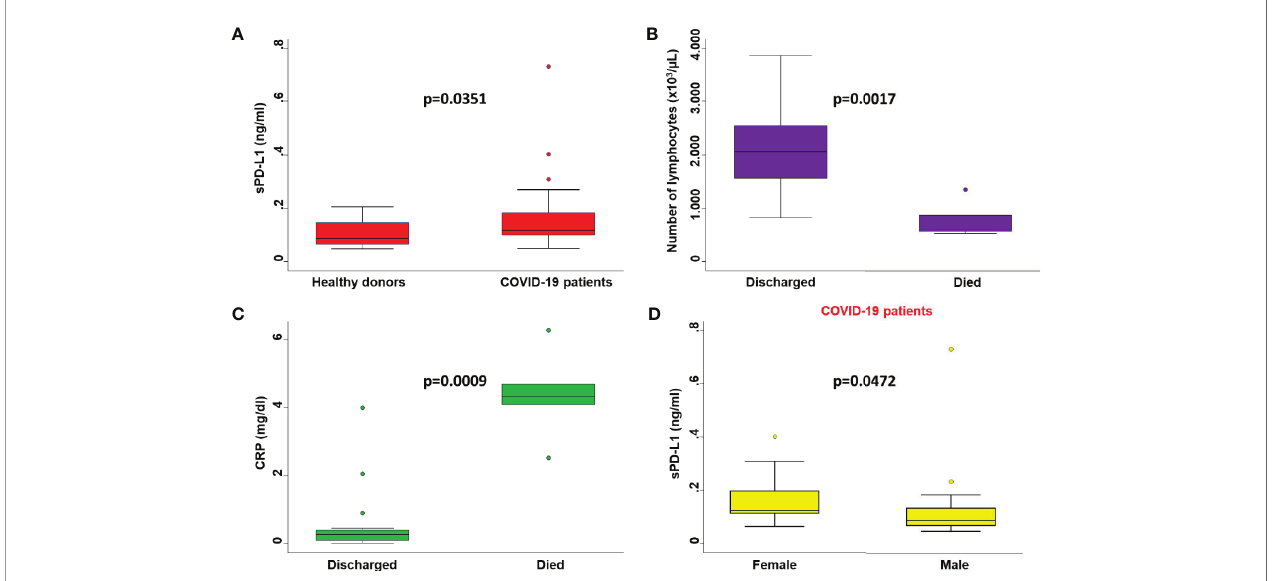
FIGURE 1 | Comparisons between serum levels of biochemical parameters in patients with different clinicopathological characteristics. (A) Serum levels of sPD-L1 in COVID-19 patients were compared with those of healthy donors by Mann-Whitney U test. (B) The number of peripheral lymphocytes in COVID-19 patients who died or were discharged from the hospital were compared by the Mann-Whitney U test. (C) Serum levels of CRP in COVID-19 patients who died or were discharged from the hospital were compared by the Mann-Whitney U test. (D) Serum levels of sPD-L1 in male and female COVID-19 patients were compared by the Mann-Whitney U test. On each box, the central mark is the median, the edges of the box are the 25th and 75th percentiles, the whiskers extend to the most extreme data points not considered outliers, and outliers are plotted individually. p was considered signi fi cant if < 0.05.